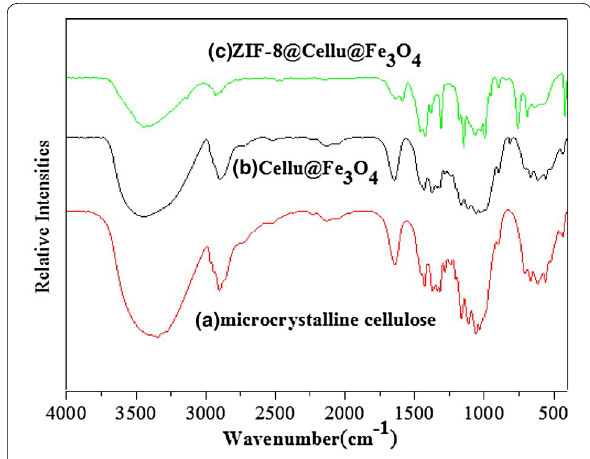
Fig. 2 FT‑IR spectra of microcrystalline cellulose ( a ), Cellu@Fe 3 O 4 ( b ), and ZIF‑8@Cell@Fe 3 O 4 ( c ).